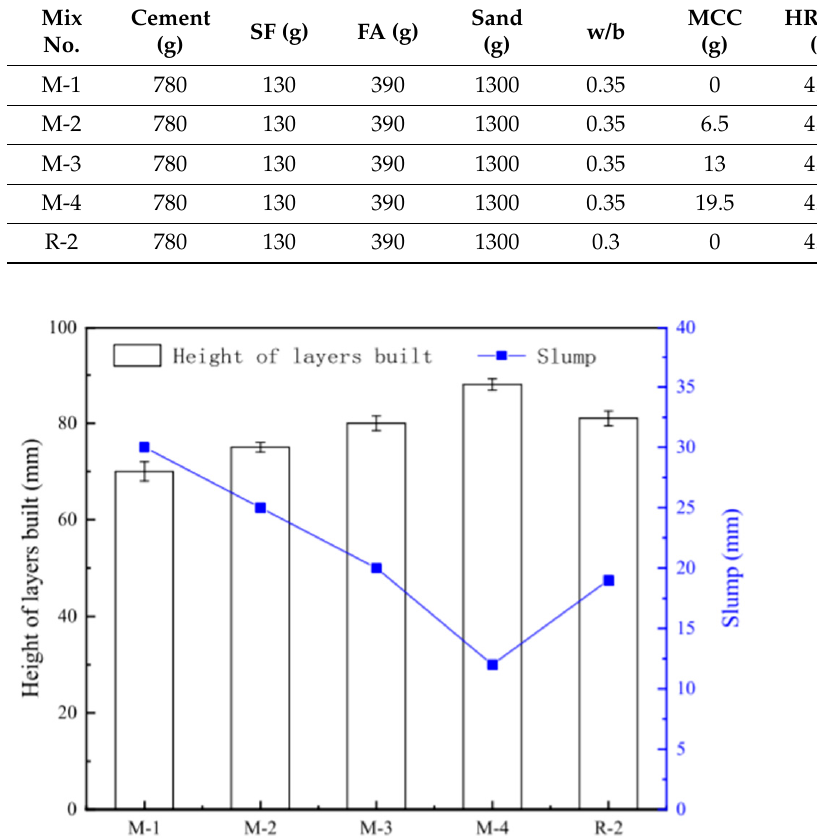
Figure 5. Buildability of different mix proportions: heights of the built layers. Reprinted with permission from ref. [30]. Copyright 2019 Elsevier Ltd.